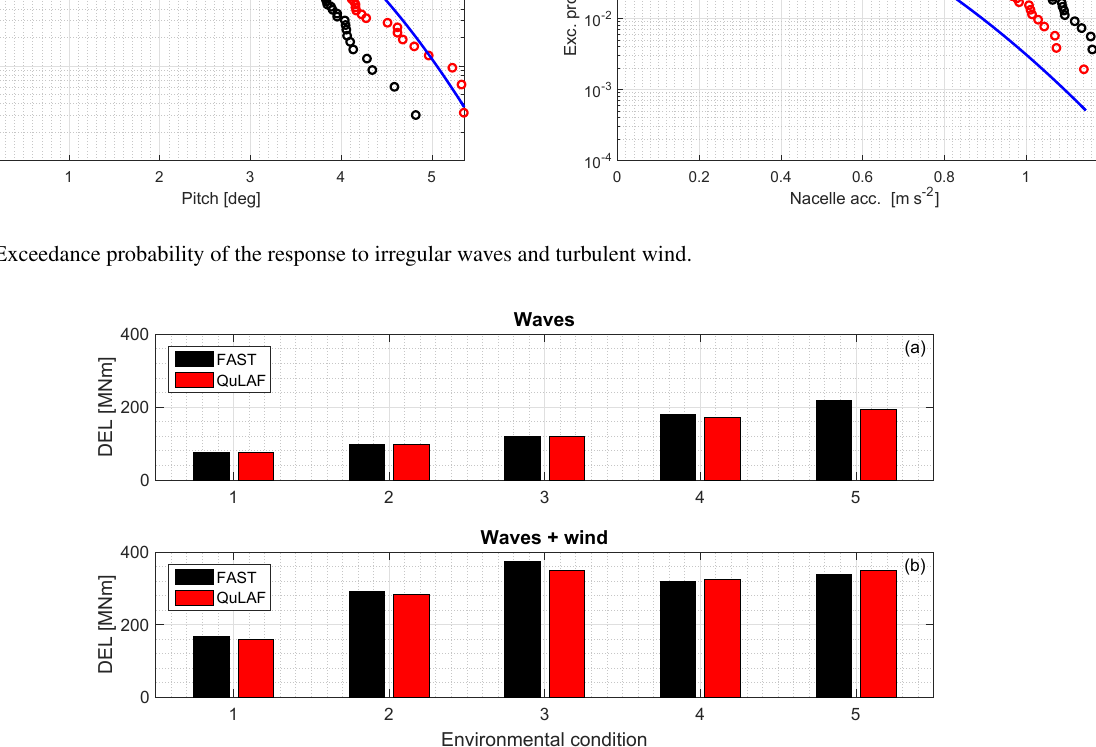
the model: (i) underprediction of hydrodynamic loads in se- vere sea states due to the omission of viscous drag